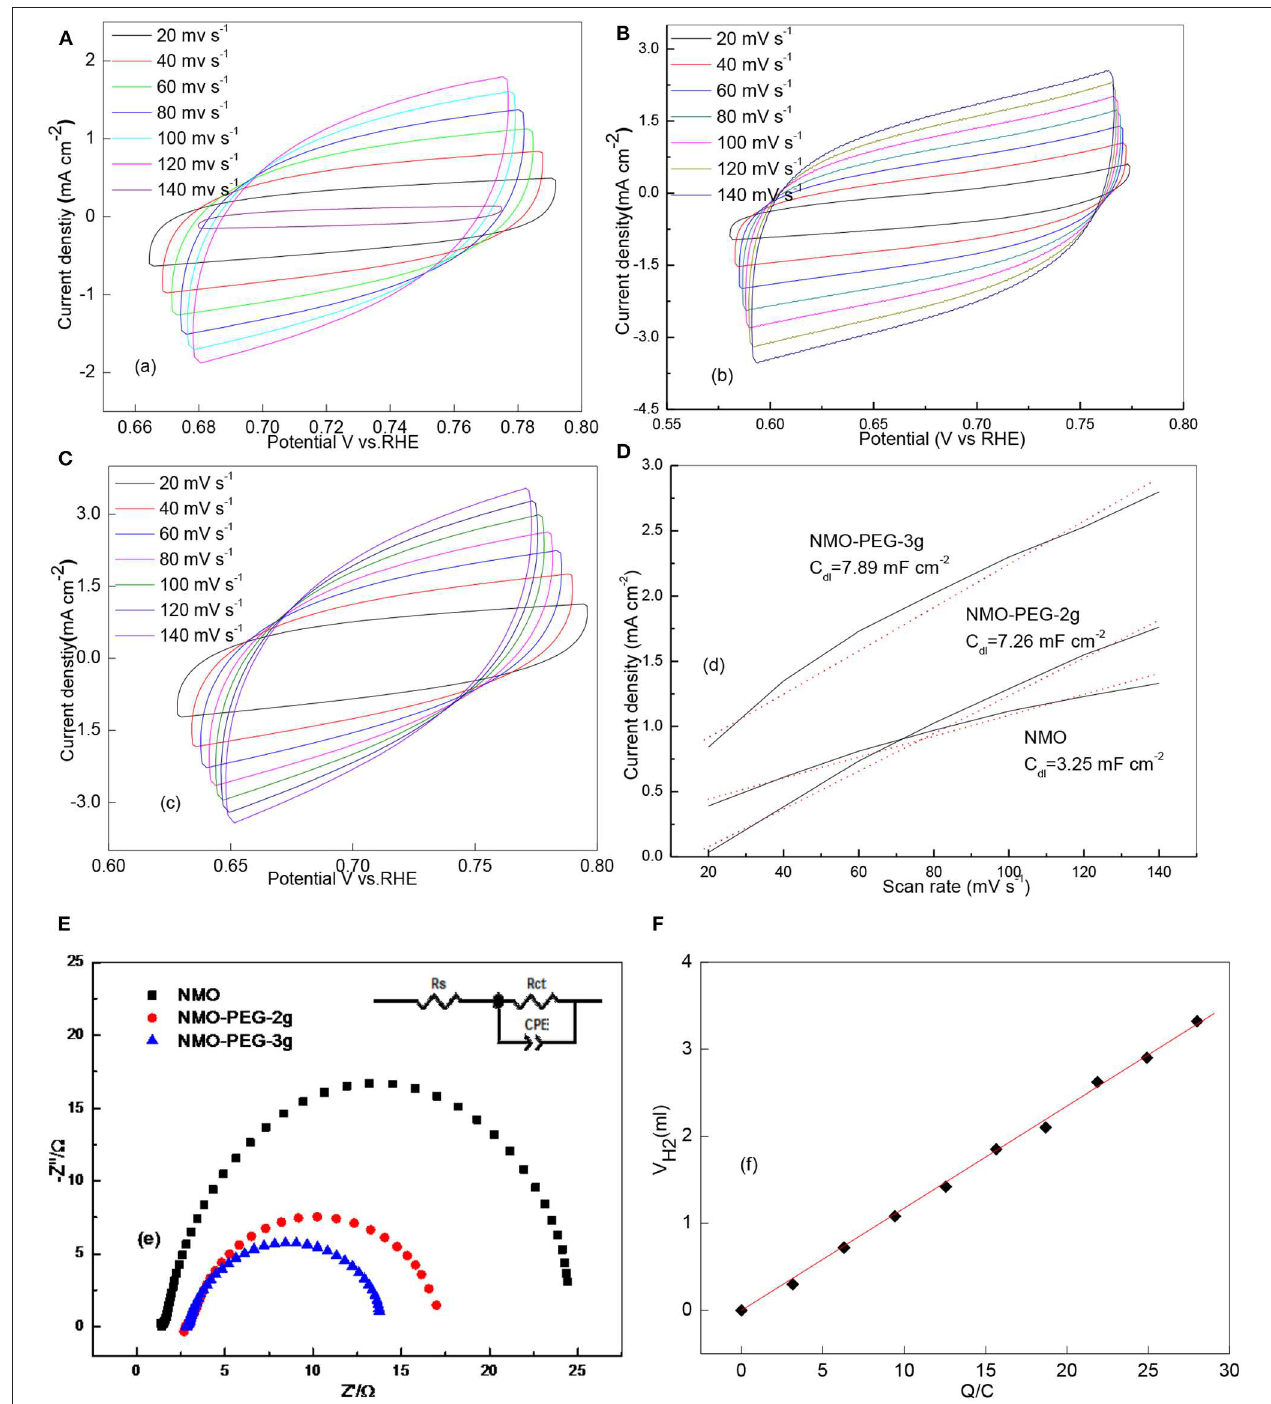
FIGURE 4 | (A) CV curves of NMO; (B) CV curves of NMO-PEG-2g; (C) CV curves of NMO-PEG-3g (at different scan rates of 20, 40, 60, 80, 100, 120, and 140mV s − 1 in the non-faradaic potential region in 1M KOH); (D) current density variation plotted against scan rate fitted to a linear regression enables the estimation of C dl ; (E) Nyquist plots of as-prepared catalysts; (F) quantitative H 2 measurement via water displacement.